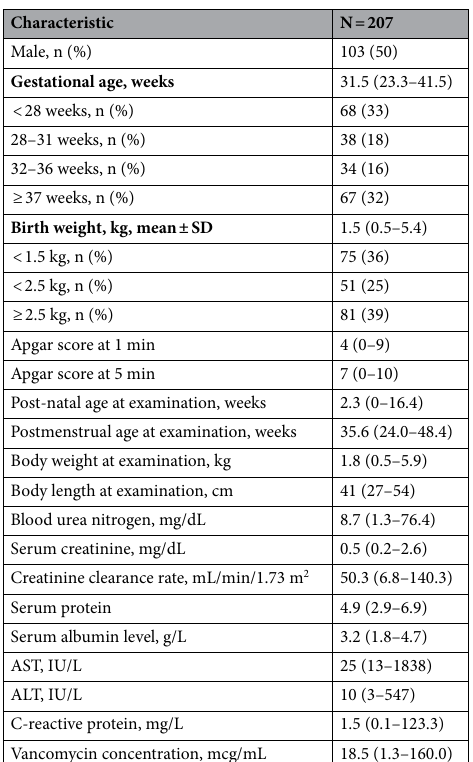
Table 1. Demographic and clinical characteristics of the study population. Data are presented as median (range). AST aspartate transaminase, ALT alanine